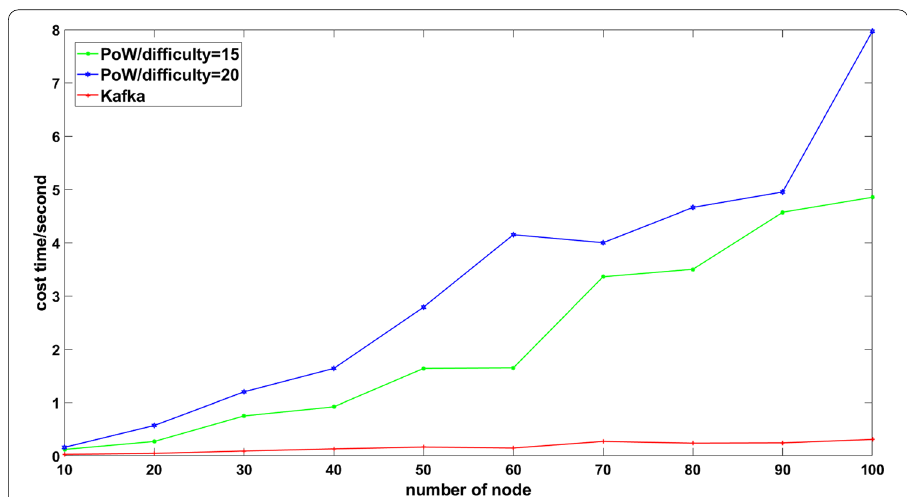
Fig. 16 Comparison of Kafka and PoW in the time of reaching